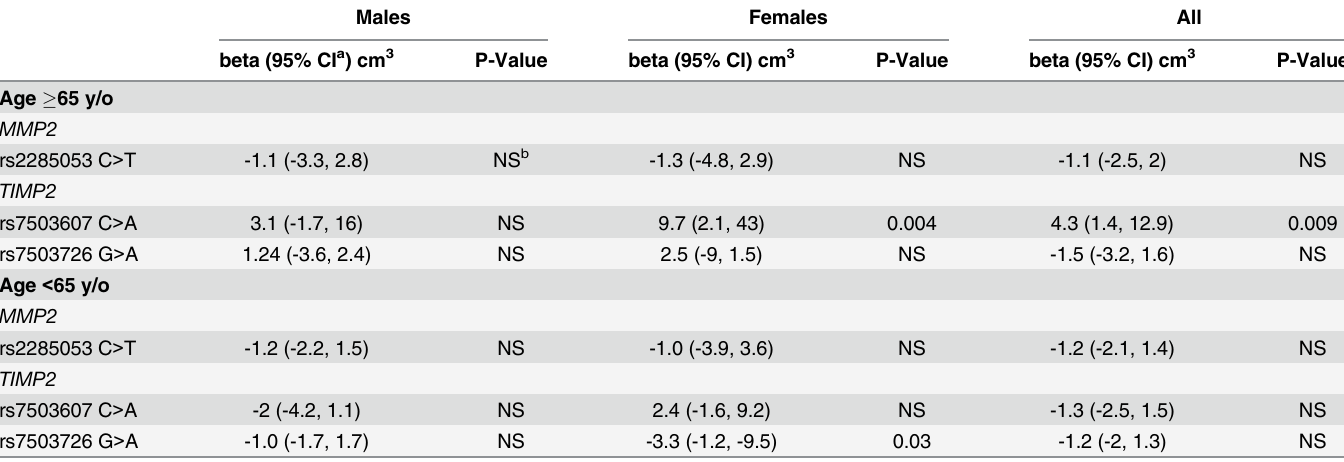
SNP on hemorrhage